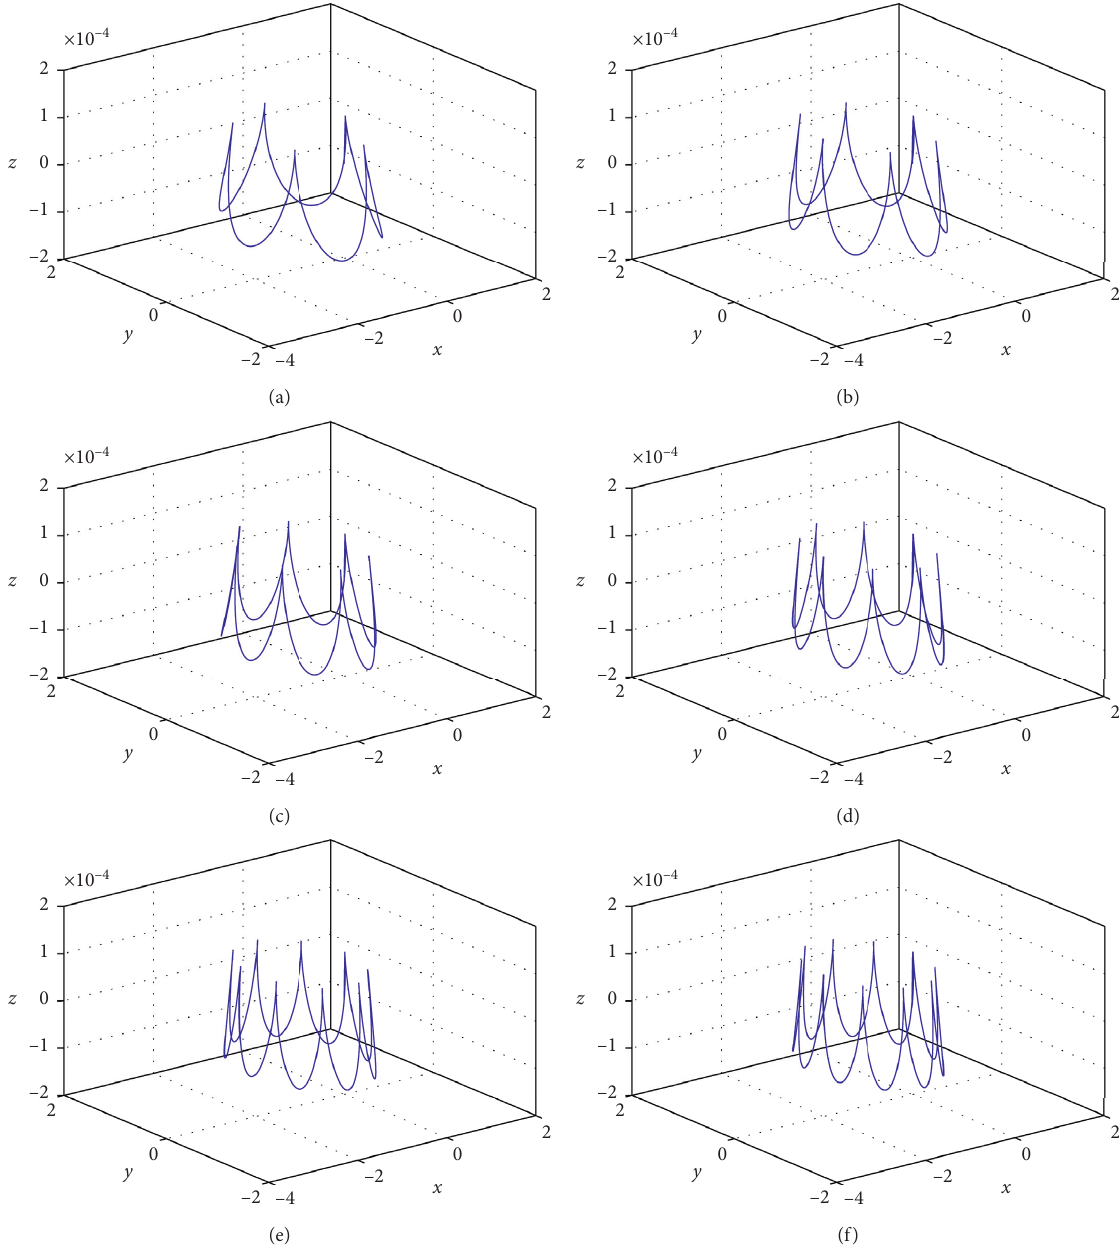
Figure 4: Periodic orbits when e � 0 . 1 and f 0 � π /3 and velocity _ y 0 � 0 . 005. (a) Five-loop orbit, when x 0 � 0.026250375000. (b) Six-loop orbit, when x 0 � 0.022008125000. (c) Seven-loop orbit, when x 0 � 0.018857650000. (d) Eight-loop orbit, when x 0 � 0.016425375000. (e) Nine- loop orbit, when x 0 � 0.01449068105. (f) Ten-loop orbit, when x 0 �